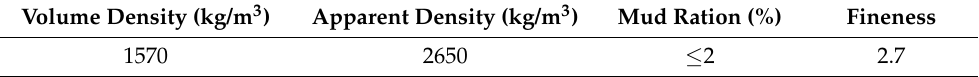
Table 2. Physical properties of sand. Table 3. Basic physical index of cement.